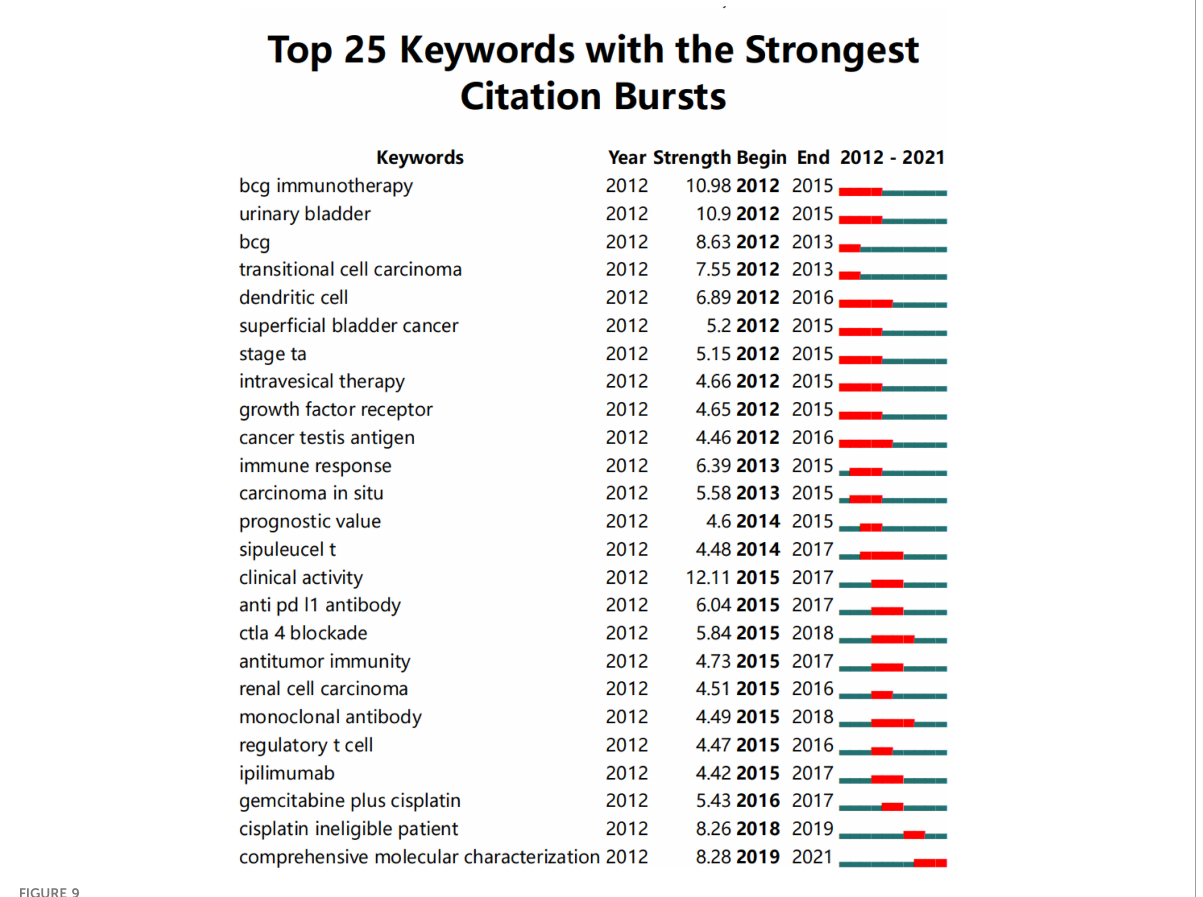
FIGURE 9 The top 25 keywords with the highest citation bursts in BC immunotherapy (generated by CiteSpace software).